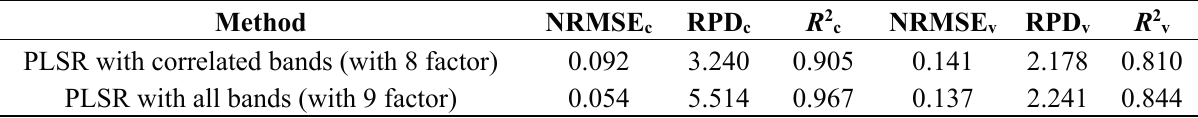
Figure 7. The scatterplot of estimated and expected the Pb concentration in ( a ). PLSR (3), ( b ). PLSR (9), ( c ). PLSR with correlated bands and ( d ). PLSR with all bands. Table 6. Evaluation criteria for PLSR with correlated and all